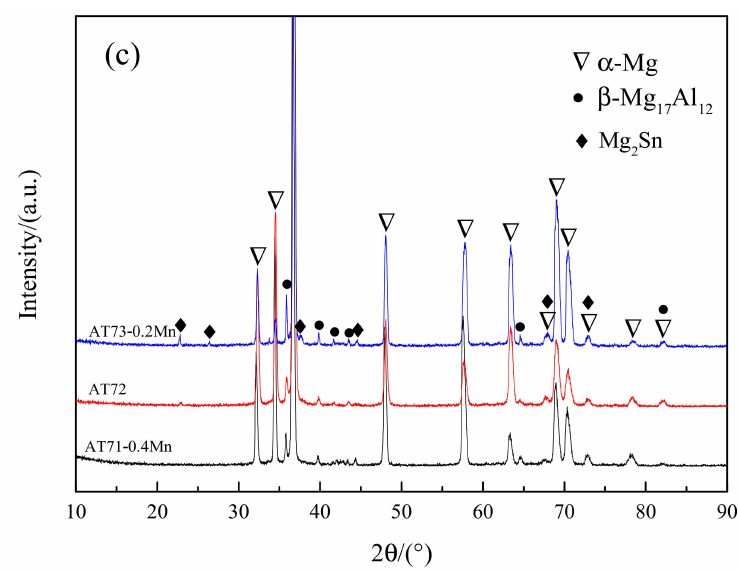
Figure 1. X-ray diffraction (XRD) results of as-cast Mg-Al-Sn-Mn alloys ( a ) AT51, AT52-0.2Mn, AT53-0.4Mn; ( b ) AT61-0.2Mn, AT62-0.4Mn, AT63; ( c ) AT71-0.4Mn, AT72, AT73-0.2Mn.